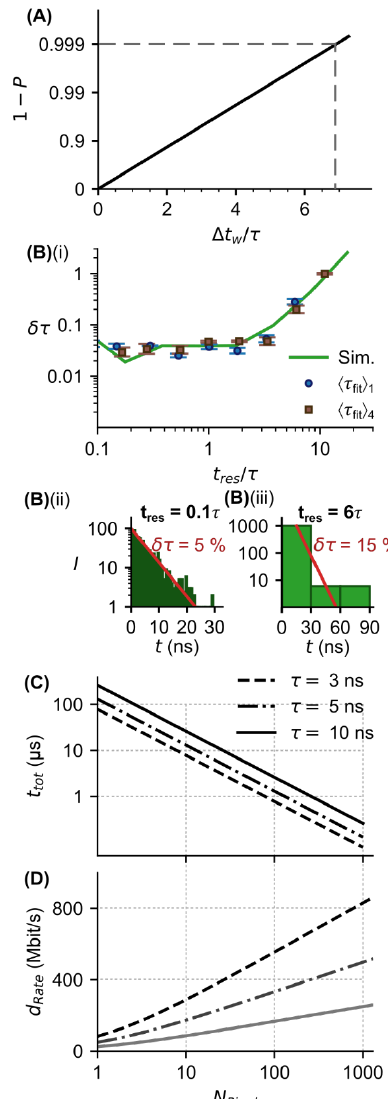
Figure 10. SPAD array detector: impact of the number of pixels on the total measurement time and data rate. ( A ) Proportion of emitted photons that arrive at the detector within the measurement window duration t w (normalized by the lifetime). A total of 99.9% of emitted photons arrive at the detector within t w / τ = 7. ( Bi ) Relative accuracy of lifetime acquisition from fitting the histograms depends on the binning, i.e., time resolution of the detector (for N c = 1000). Experimental measurements (blue and brown markers) and Monte Carlo simulations (green curve) show that with decreasing time resolution, δτ values are at a constant level until approx. t res = 2 τ and then becoming larger, reaching δτ = 10% at t res = 4 τ due to the increasing impact of noise (e.g., DCR, stray light). Representative histograms for simulated data show that at a low time resolution of t res = 6 τ ( Bii ) almost all photon counts from the fluorescence signal are in the first bin. The other bins only contain photon counts from noise source, resulting in a higher (cid:104) ∆ τ / τ (cid:105) value (lower accuracy) after fitting compared with a high time resolution of t res = 0.1 τ ( Biii ). ( C ) Total measurement time vs. number of pixels for different lifetimes. With increasing lifetime τ the total measurement time t tot increases according to Equation (10), since t w must be longer if almost all emitted photons should arrive within t w . With increasing number of pixels N Pixel the total measurement time t tot decreases according to Equation (11), since higher count rates can be tolerated (Figure 9). ( D ) Relationship between estimated required data rate of SPAD array detector with on-chip digital signal processing (CMOS device) and number of pixels for different lifetimes (time resolution t res was set to 4 τ ). As the number of pixels increases, the data rate increases according to Equation